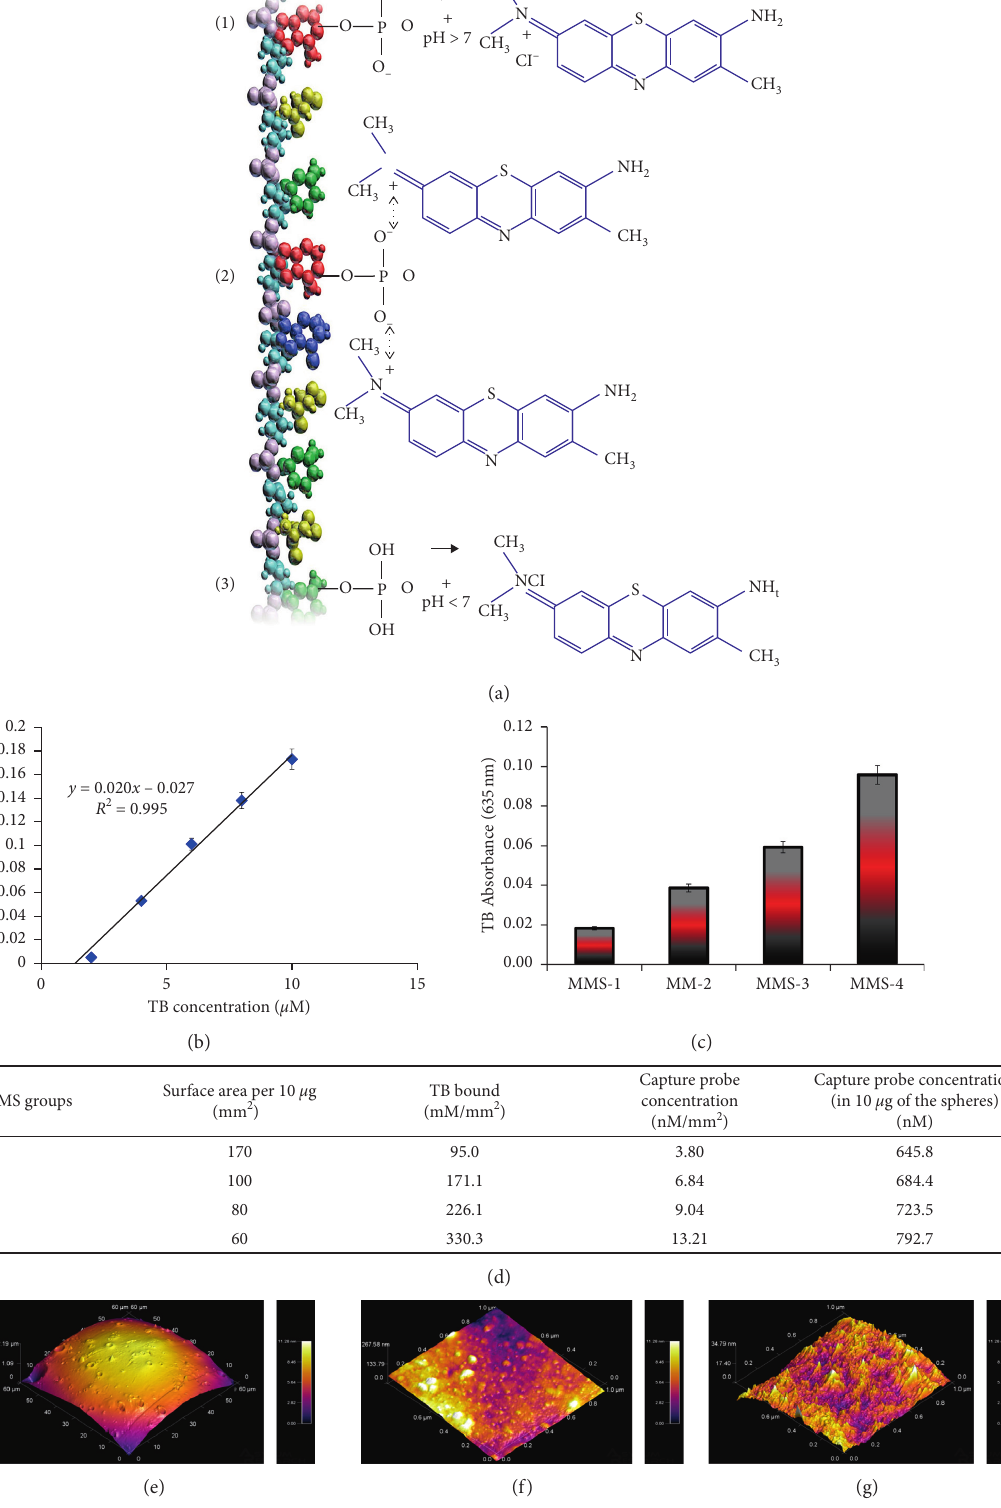
Figure 3: TB analysis for indirect confirmation of the presence of capture probe on the surface of the spheres: (a) adsorption and desorption groups of the nucleotide available on the surface of the spheres via alteration of the pH from mechanisms of the TB molecules to the − PO − 4 the alkaline to acidic environment; (b) calibration curve plotted by titration of the TB assay using different concentrations of the calibration solutions (2 μ M, 4 μ M, 6 μ M, 8 μ M, and 10 μ M); (c) TB absorbance per mm 2 of the surface measured by spectroscopic UV-Vis (635nm); and (d) breakdown calculations of the TB assay. AFM analysis ((e) 60 μ m) and zoomed-in view ((f) 10 μ m) of the microspheres prior to immobilization and ((g) 10 μ m) after surface attachment of the hybrid strands which shows the clear alteration of the surface